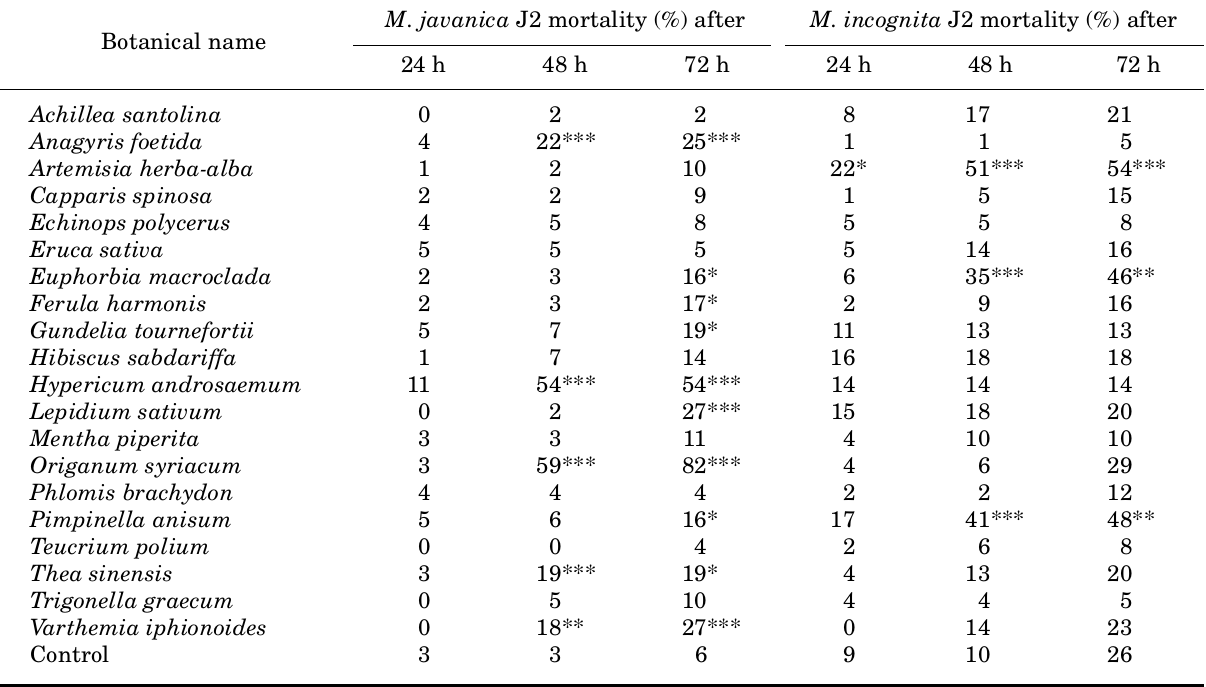
Table 2. Effect of twenty plant extracts (20 µ g ml -1 ) on mortality of second-stage juveniles (J2s) of Meloidogyne javanica and M. incognita